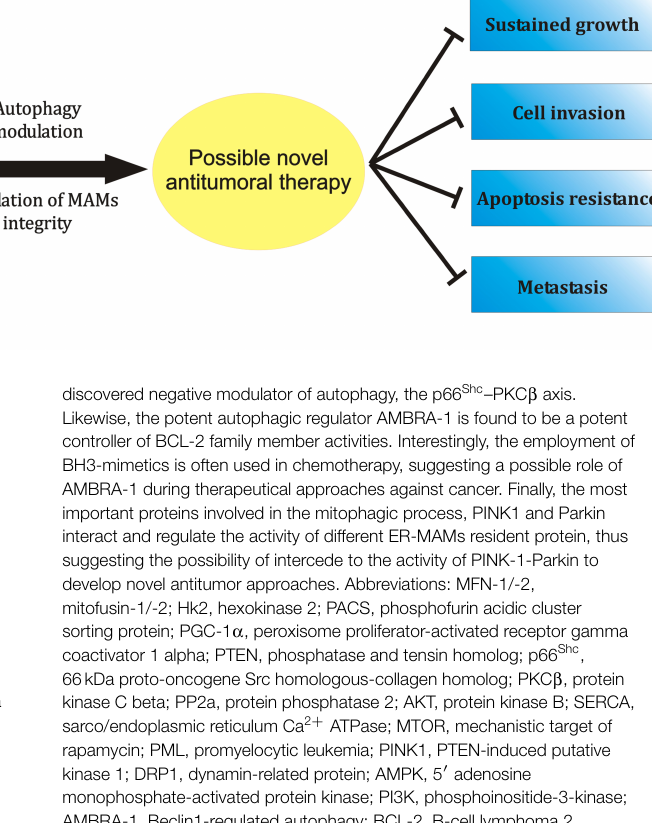
discovered negative modulator of autophagy, the p66 Shc –PKC β axis. Likewise, the potent autophagic regulator AMBRA-1 is found to be a